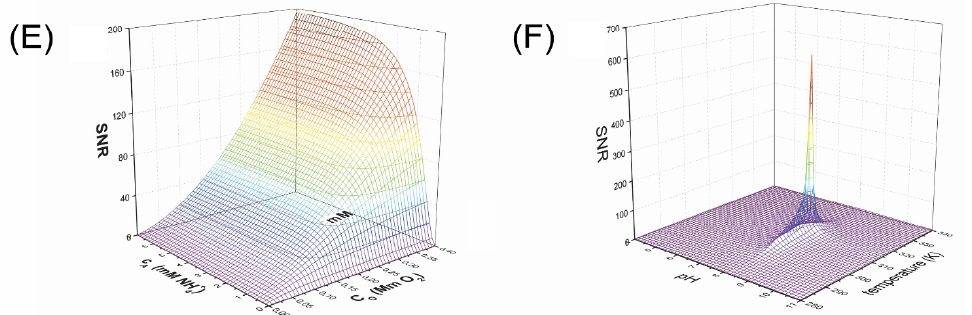
Figure 3. Dependence of signal-to-noise ratio (SNR) of ABTOW on the detection parameters: tem- perature ( A ), pH ( B ), concentrations of ammonium ( C ) and oxygen ( D ). The SNR is shown using dotted lines (green). The corresponding rates of nitrification are shown with a short dashed line (blue), while their derivative with a short dashed line (blue). Dependence of the SNR in the combined ABTOW model on substrate concentrations ( E ) and pH and temperature ( F ). The ranges of substrate concentration, temperature and pH, and units are analogous in all plots.